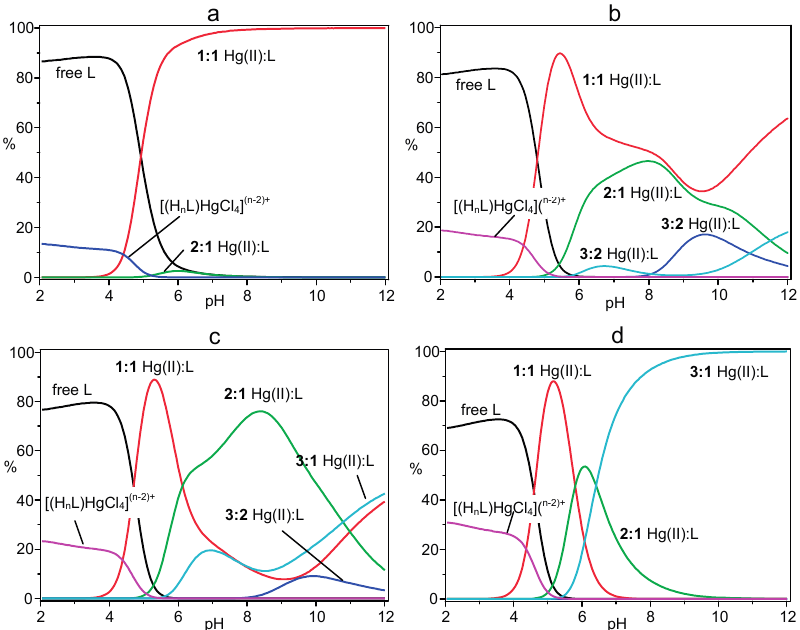
Figure 2. Cumulative distribution diagrams for the system Hg(II)/L. ( a ) [Hg(II)] = [L] = 1 × 10 − 3 M; ( b ) [Hg(II)] = 1.5 × 10 − 3 M, [L] = 1 × 10 − 3 M; ( c ) [Hg(II)] = 2 × 10 − 3 M, [L] = 1 × 10 − 3 M; ( d ) [Hg(II)] = 3 × 10 − 3 M, [L] = 1 × 10 − 3 M. [Cl − ] = 0.1 M in all